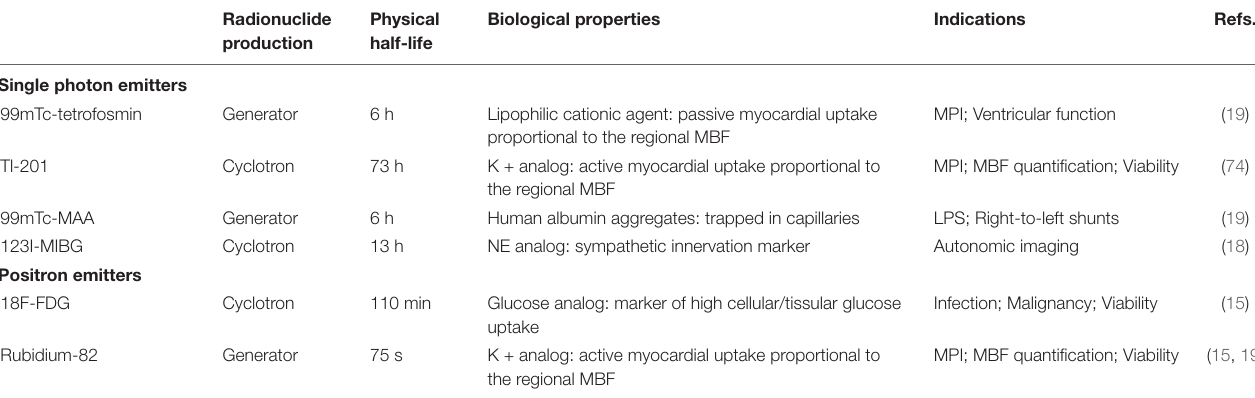
TABLE 1 | The main radiopharmaceuticals in pediatric cardiology.